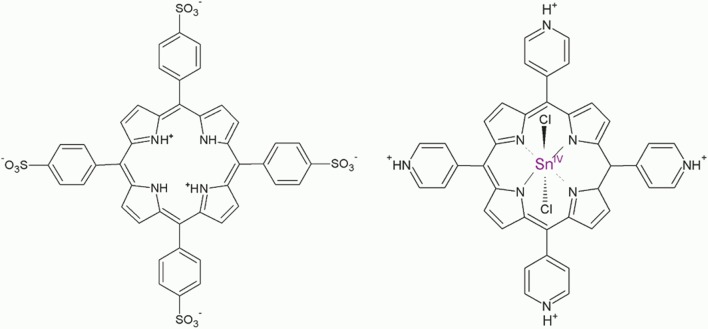
Structures of the porphyrin diacid H4TPPS42- and Sn(IV)TPyP4+ (pyridyl groups are shown in the protonated state).